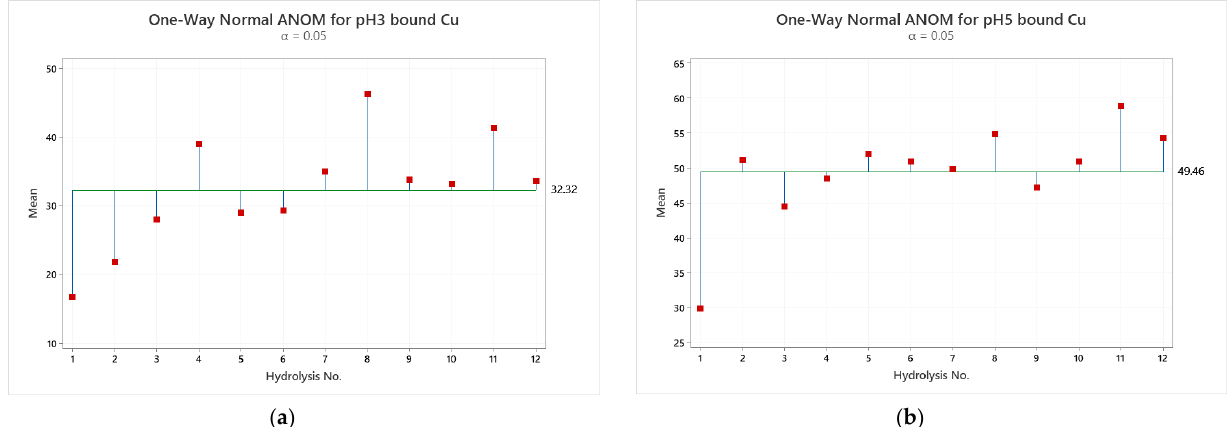
Figure 5 . ( a ) One-Way Analysis of Means for bound Cu at pH 3; ( b ) One-Way Analysis of Means for bound Cu at pH 5. 1 – 12 refer to the individual hydrolysates outlined in Table 1.